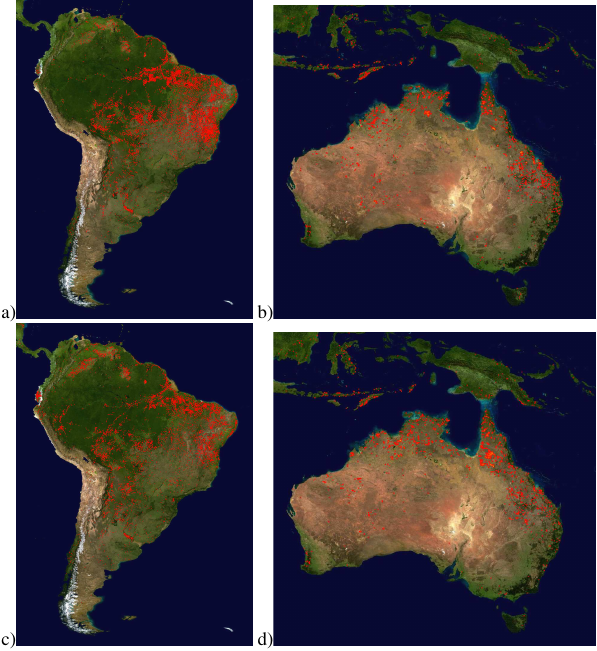
Fig. 3. MODIS-derived fire maps (red pixels define detected fire locations) for: a) South America over the period 27 Oct 2008 - 5 Nov 2008; b) Australasia over the period 27 Oct 2008 - 5 Nov 2008; c) South America over the period 6 Nov 2008 - 15 Nov 2008; d) South America over the period 6 Nov 2008 - 15 Nov 2008.